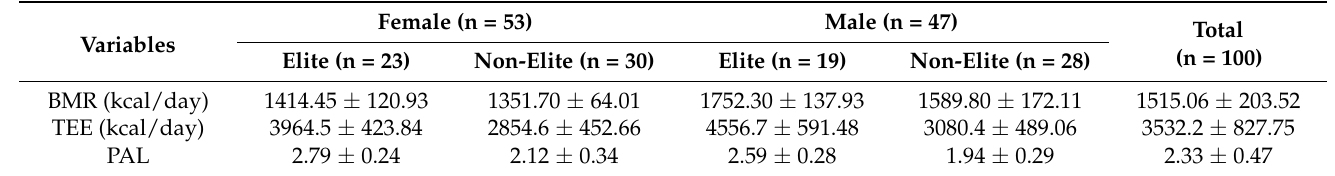
Table 3. Physical activity contour of elite and non-elite athletes.